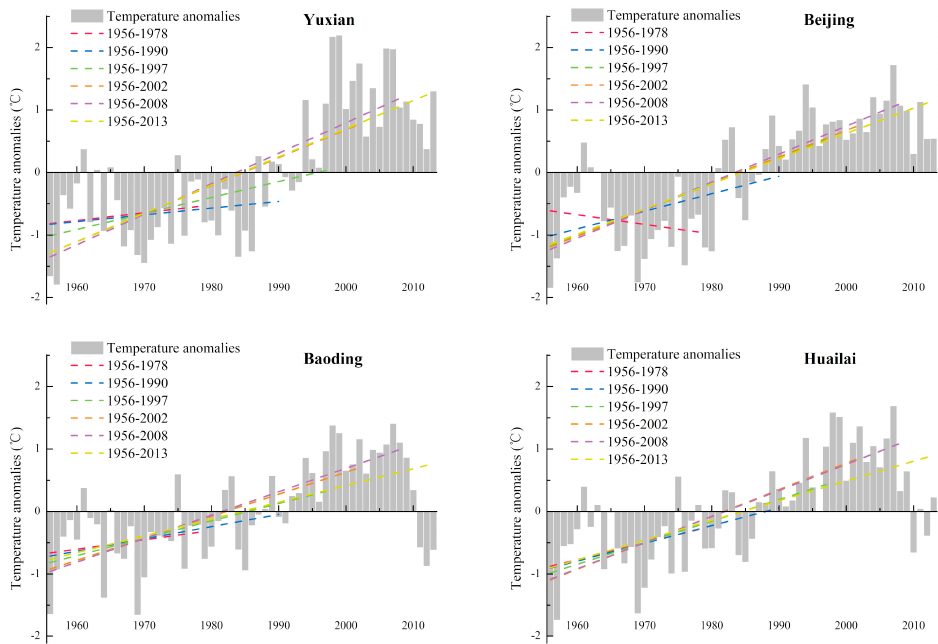
Figure 11. The trend of annual region anomalies in temperature of four meteorological stations.